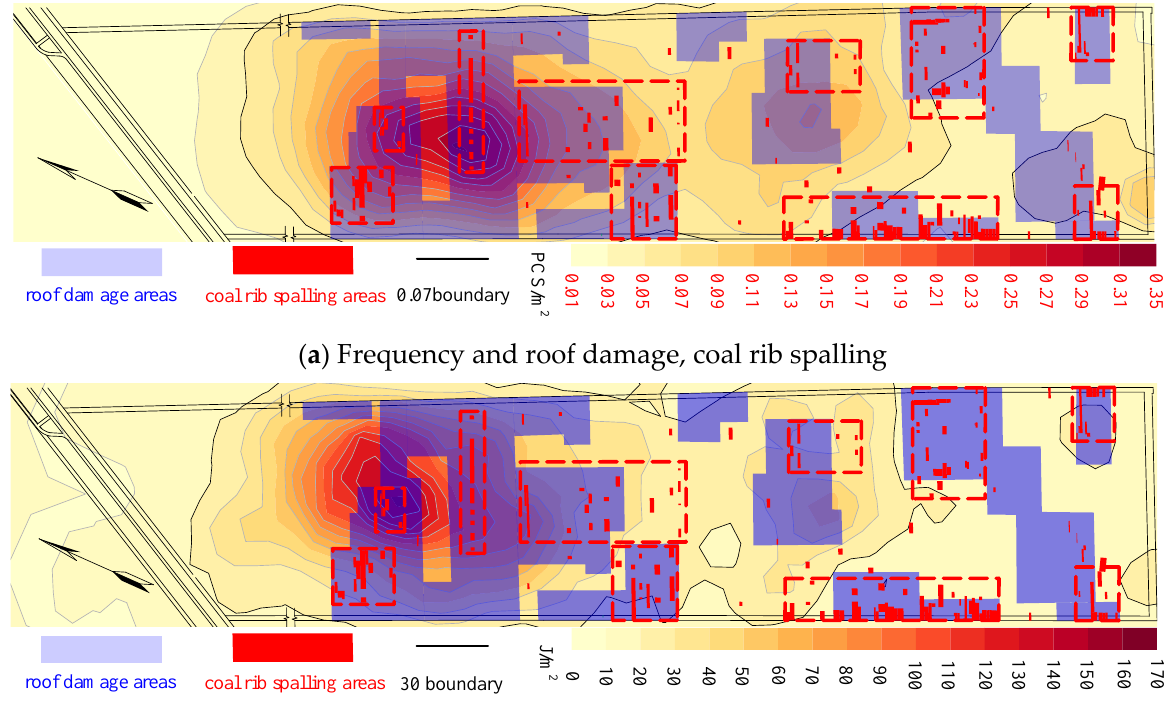
Figure 8. Spatial distribution characteristics of microseism accumulation and roof damage, coal rib spalling.